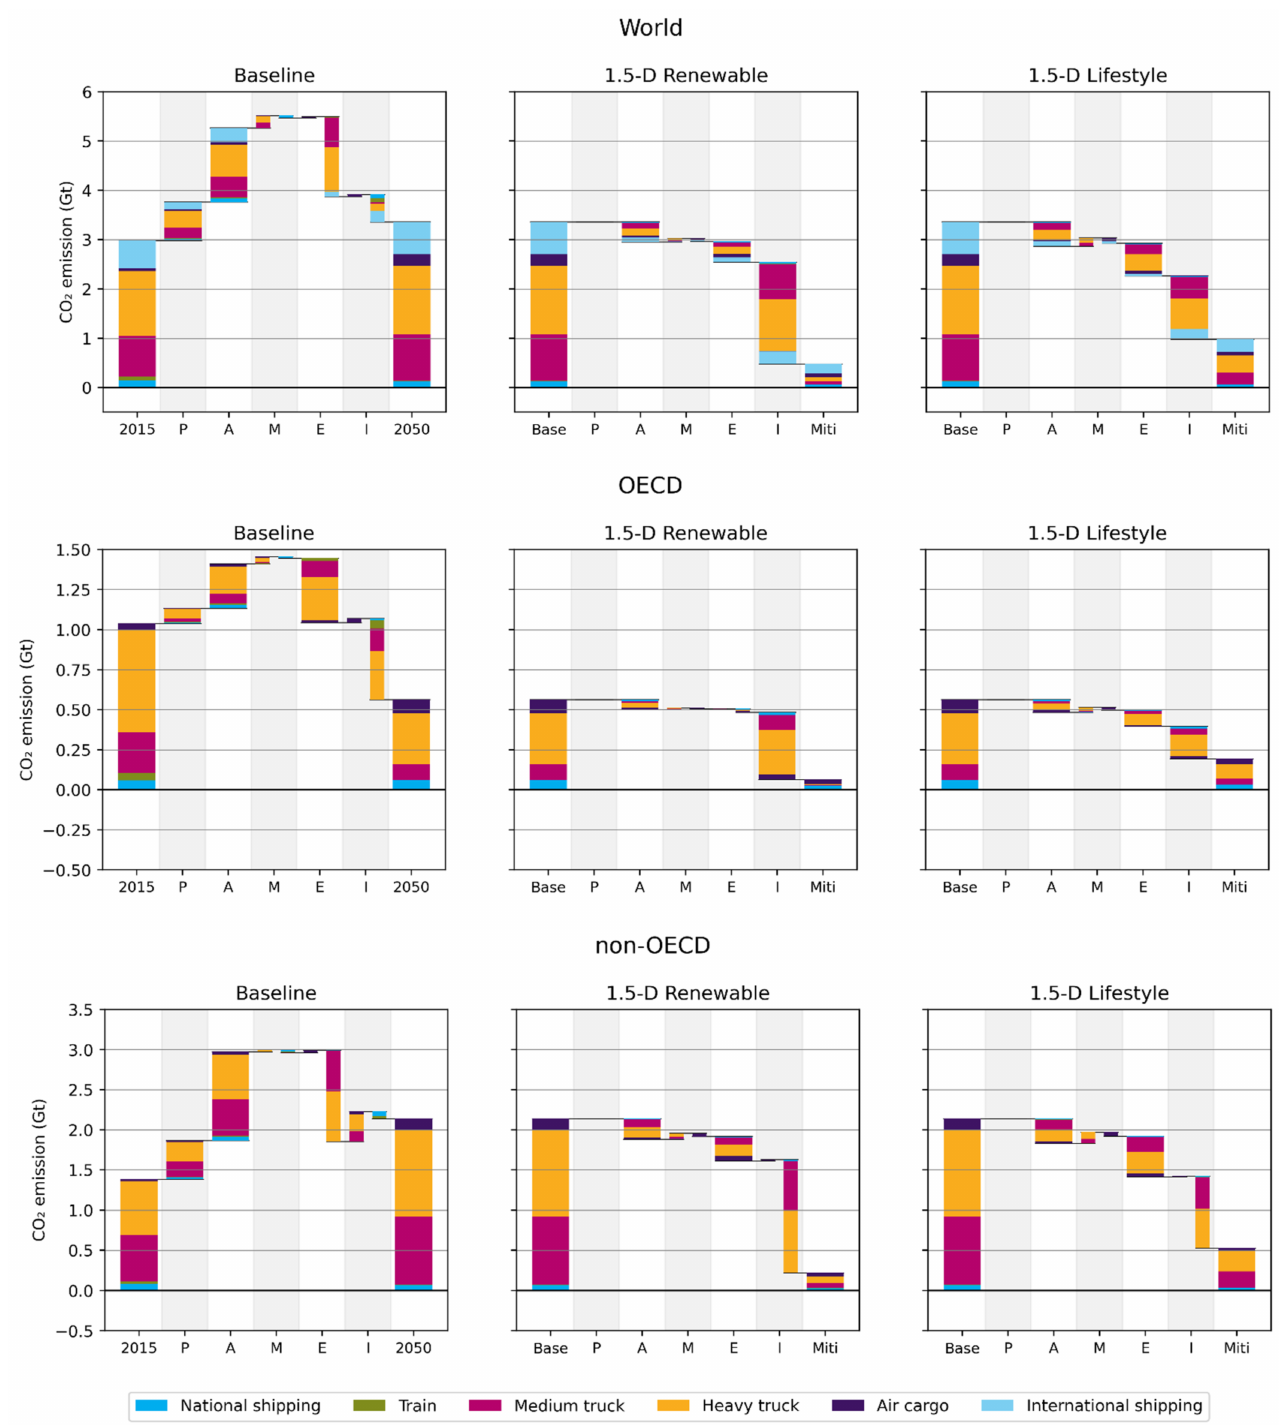
Figure 8. Changes in freight transport emissions between 2015 and 2050 (Baseline) and between the Baseline and mitigation scenarios (in 2050) due to different drivers. P: population; A: activity; M: mode, E: efficiency, I: carbon intensity (includes the impact of electrification). Emissions from international bunkers are only shown in global